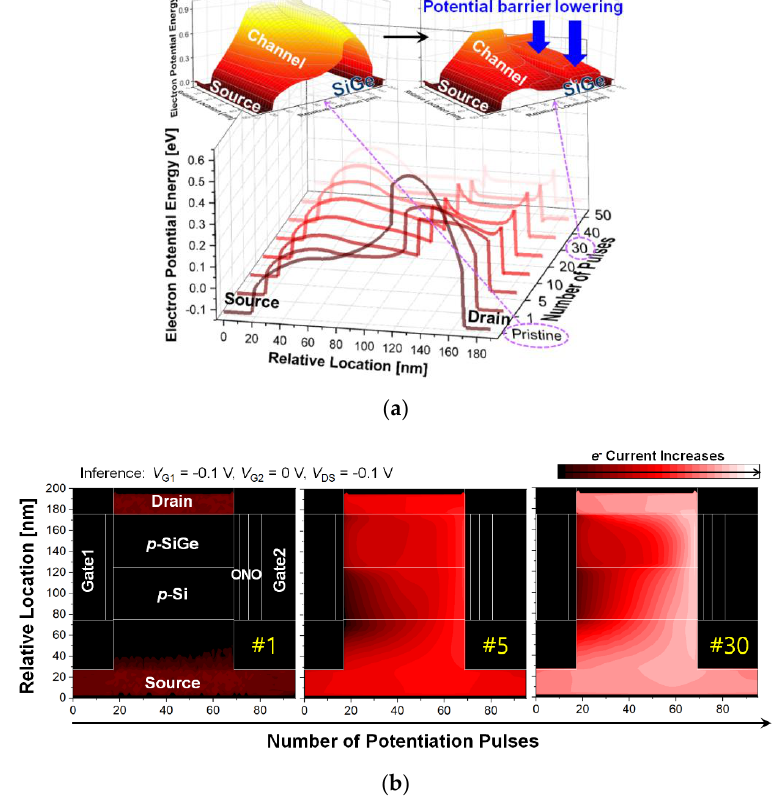
Figure 4. Analysis on potentiation operation. ( a ) Change in the conduction band surface with regard to the number of potentiation pulses: initial (left) and after 30 pulses (right). Line traces of the conduction band edges in the vicinity of gate 2. ( b ) Electron current densities after 1, 5, and 30 potentiation pulses applied to the synaptic device.